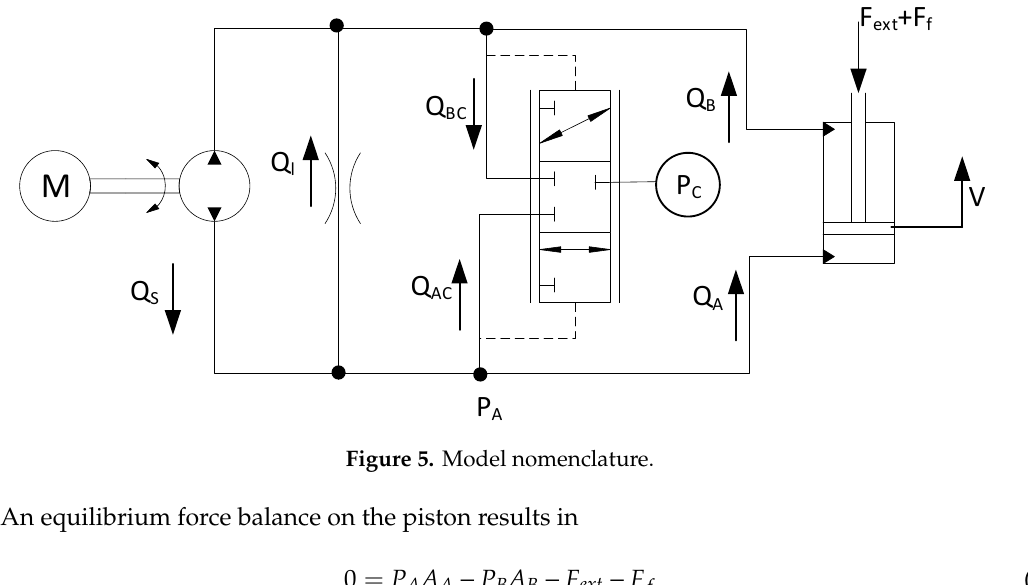
Figure 5. Model Figure 5. Model nomenclature.